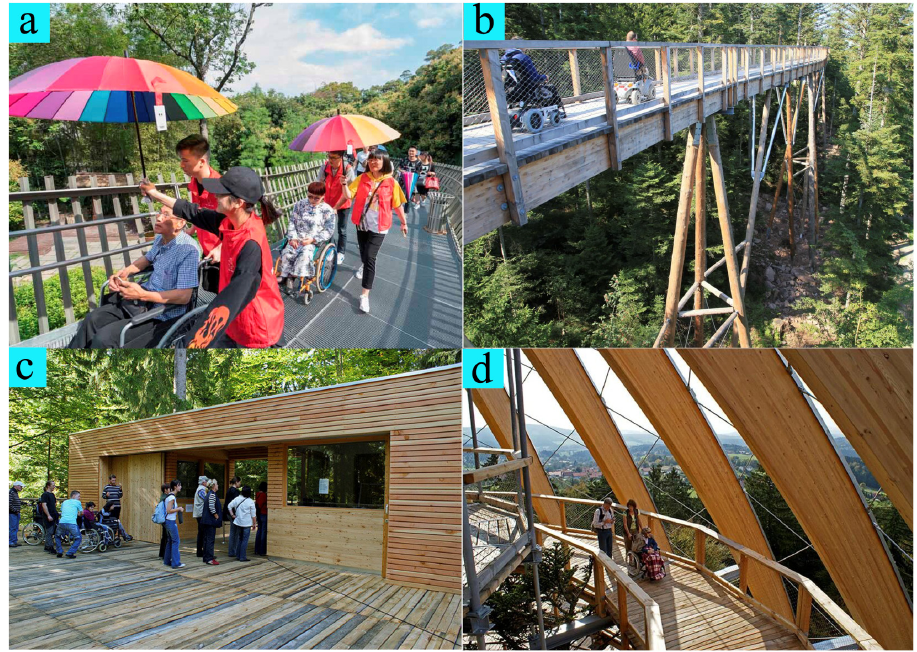
Figure A7. Treetop walkways with gentle slope changes are friendly to disadvantaged groups. The disabled in wheelchairs in ( a ) the Fu Forest Trail, ( b ) the Lipno Treetop Walkway, the Czech Republic, and ( c , d ) in the Bavarian Forest Treetop Walkway, Germany.